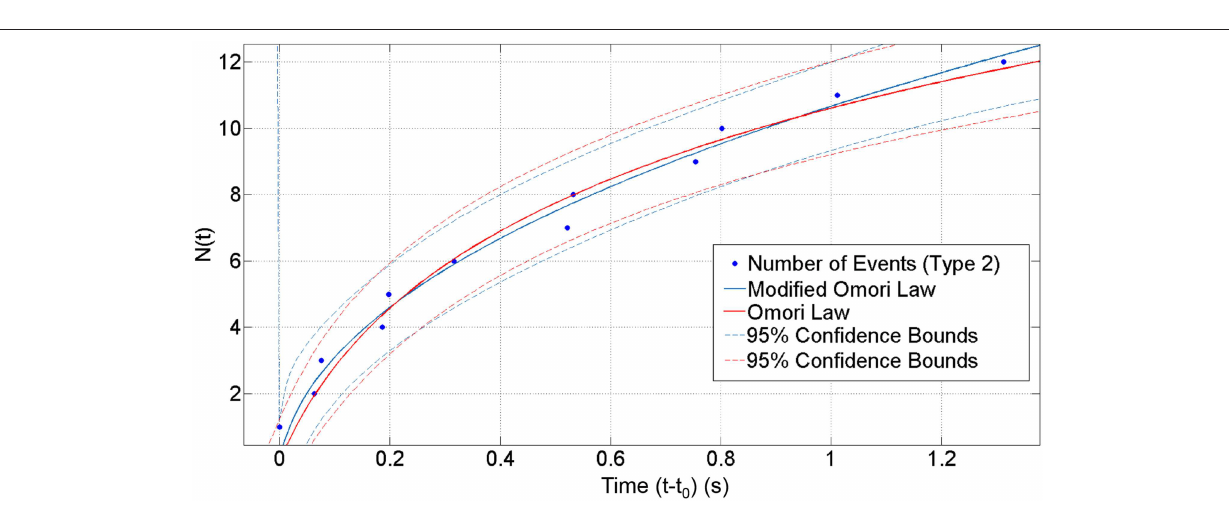
0 in this representation corresponds to time t 0 1 . 49 s after the start of the air = =